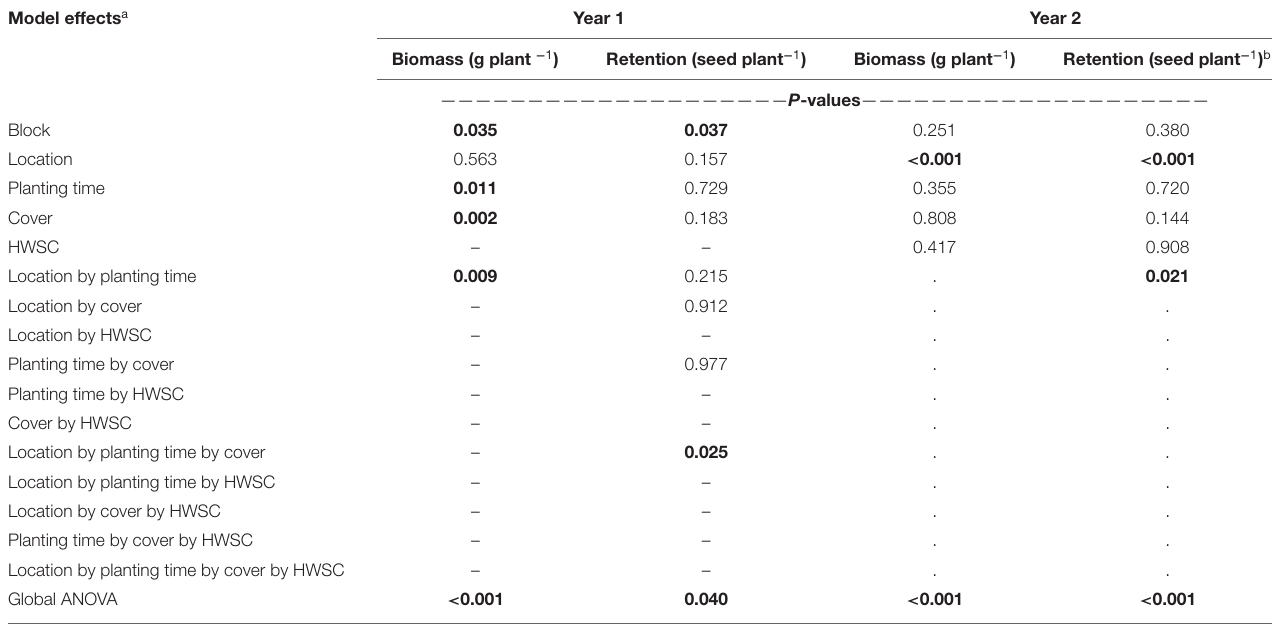
TABLE 4 | Effects table for common ragweed biomass and seed retention at soybean harvest across all locations for year 1 of the field experiment at Blacksburg and Lawrenceville, VA, USA in 2017 and Blackstone, VA, USA in